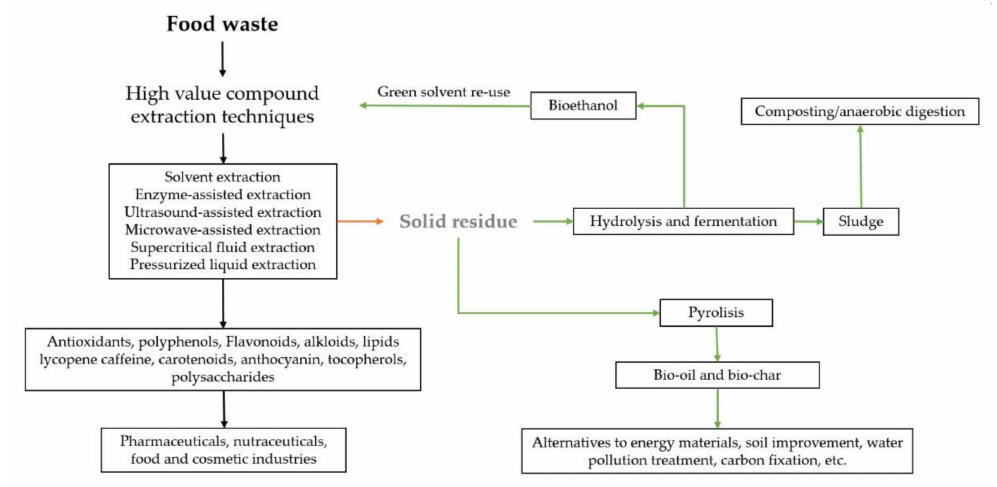
Figure 1. Biorefinery concept applied to food